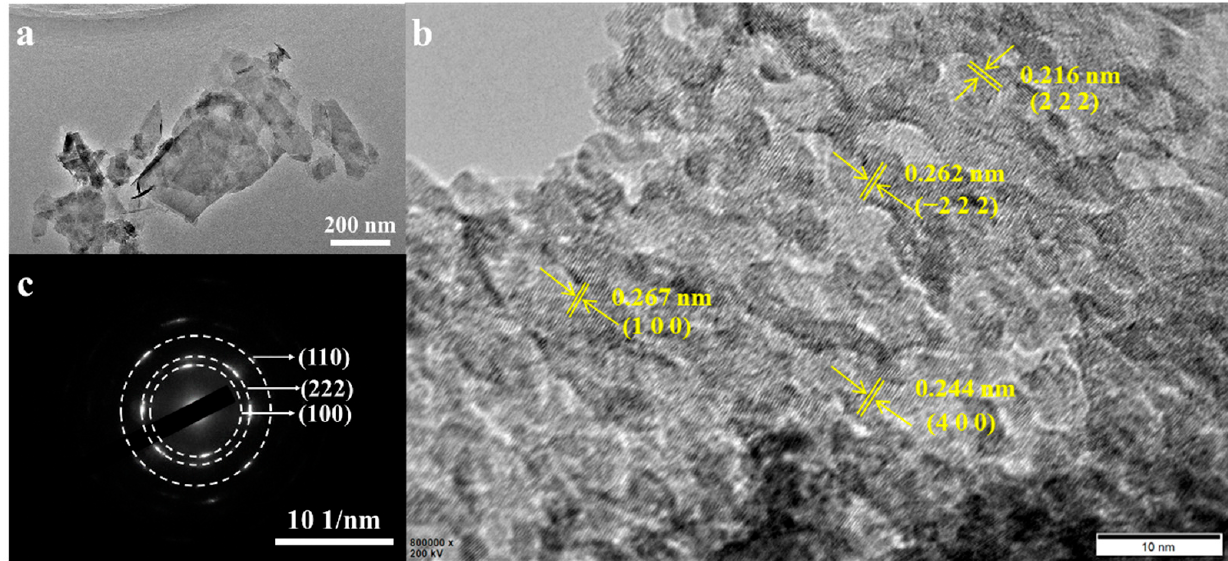
Figure 5. ( a ) TEM images, ( b ) HRTEM image and ( c ) SAED pattern of NiCoMo 2 -LDH/NF.